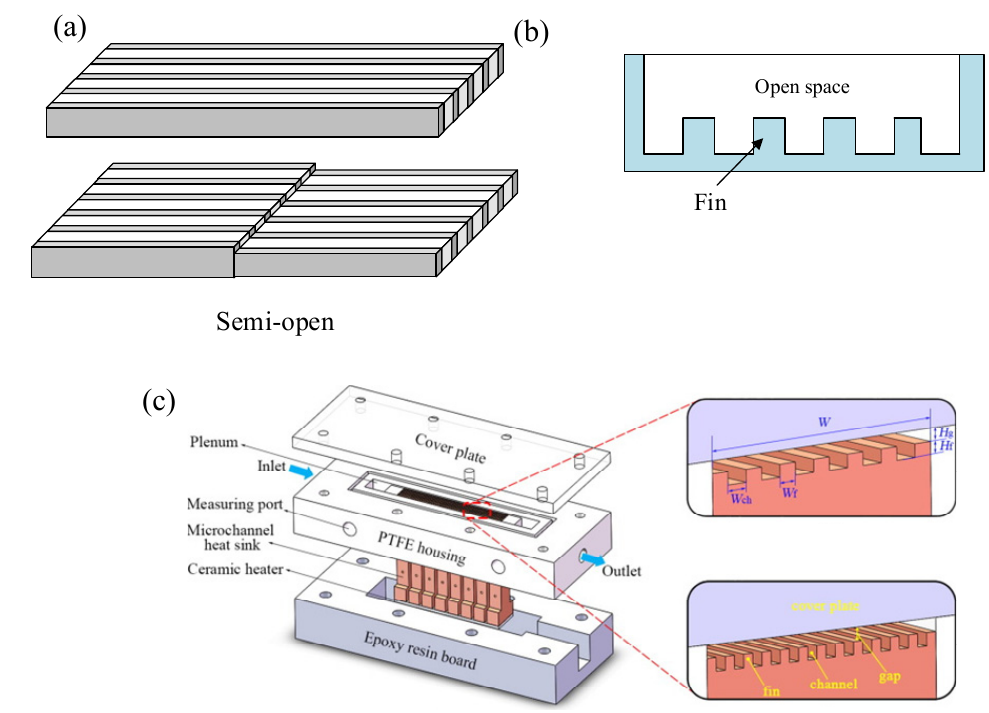
Figure 9. Schematic diagram of open microchannels: ( a ) Xia et al. ([89]), ( b ) Bhandari et al. ([93]), ( c ) Yin et al. (adapted from Ref. [91]).